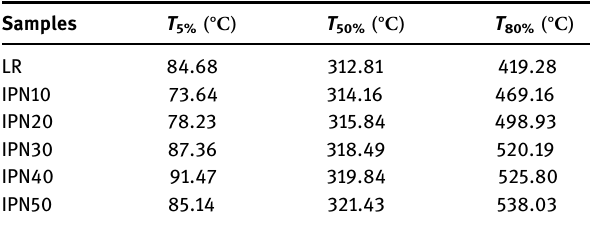
Table 1: Summary of thermal properties of IPN and LR fi lms